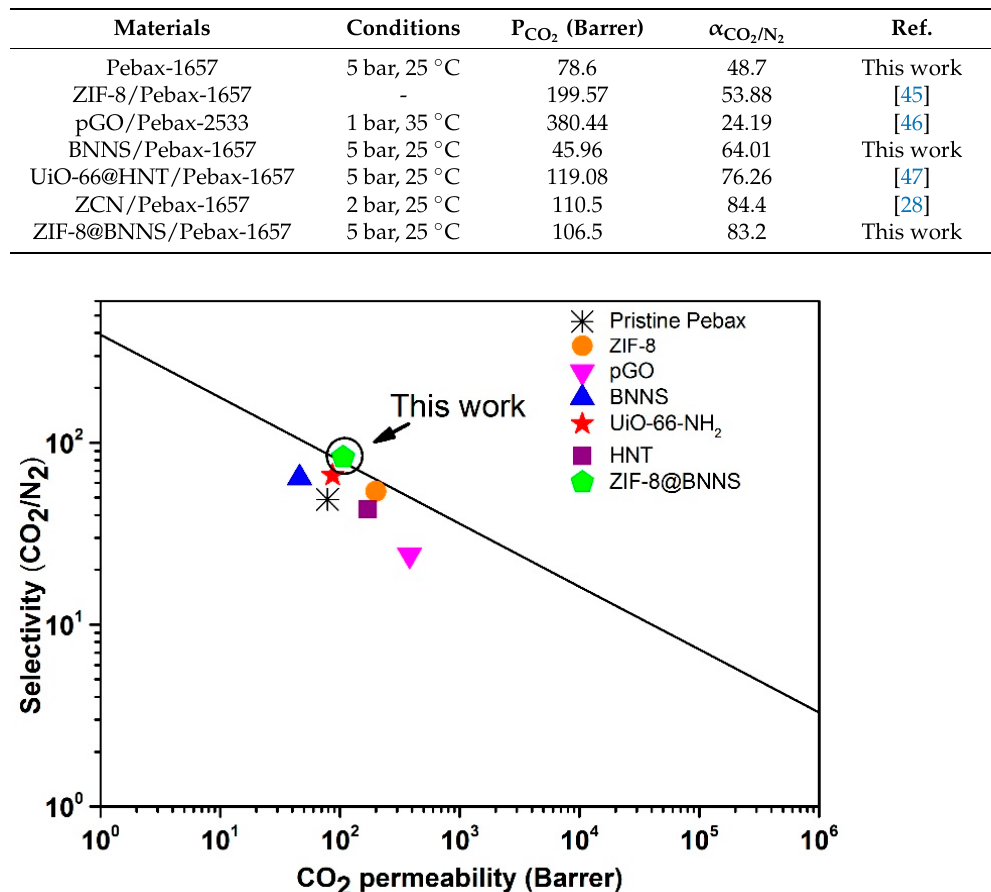
Figure 8. Comparison in mass transfer pathways for MMMs containing BNNS and ZIF-8@BNNS.